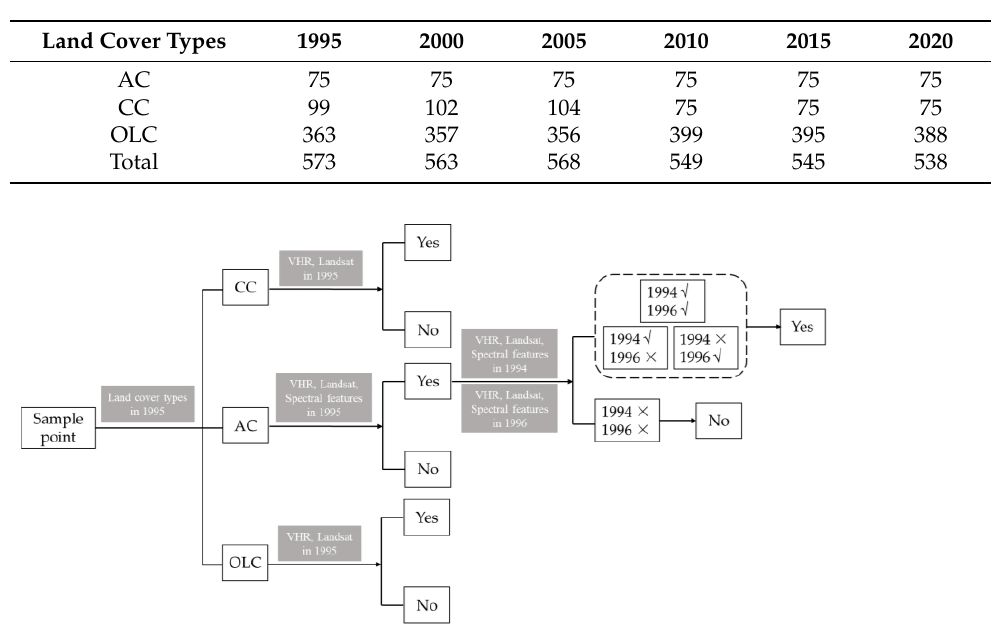
Table 2. Accuracy assessment of annual land cover classification model based on field surveys data.